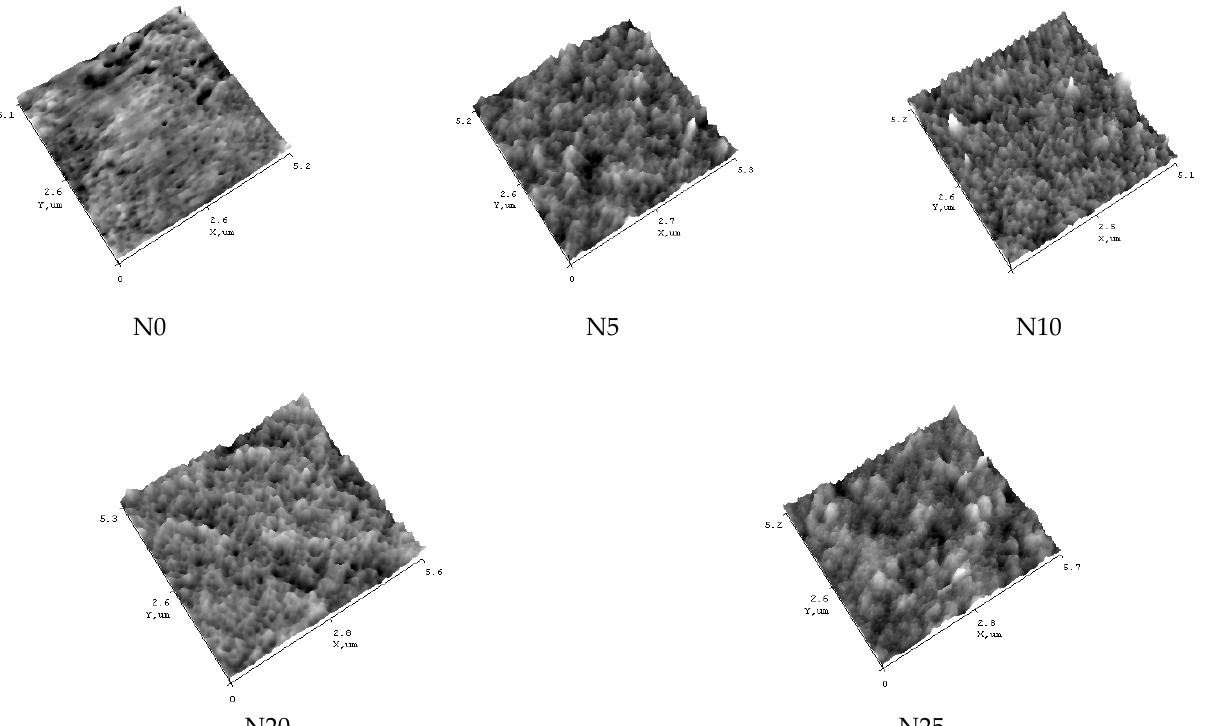
Figure 2. SEM microphotographs of selective layer surface of TFC membranes, content of Al 2 O 3 ·SiO 2 nanoparticles, wt.%: ( a )—0, ( b )—25 wt.%.